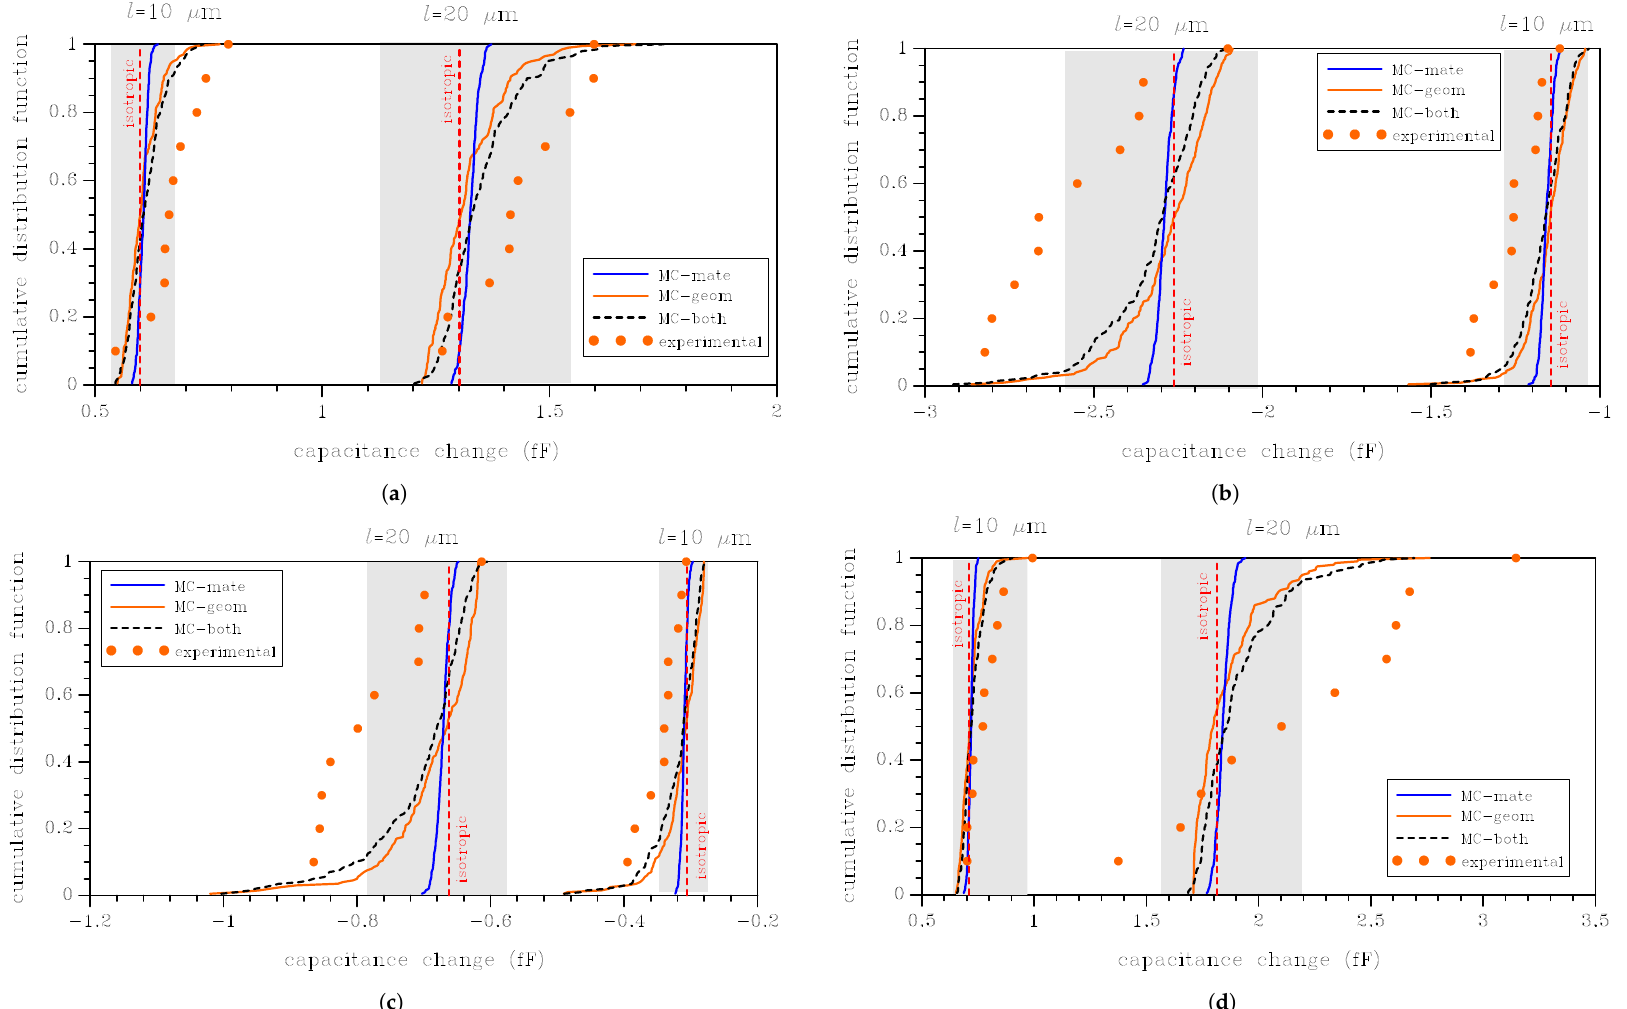
Figure 5. Comparison between numerical and experimental cumulative distribution functions: ( a ) RR; ( b ) RL; ( c ) LR; and ( d ) LL test